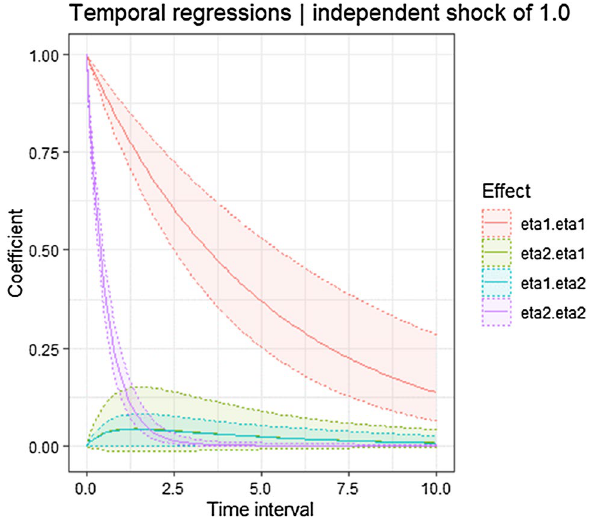
Figure 2. Representation of discrete time parameters of auto- and cross-effects of the Hierarchical Bayesian Continuous Time Dynamic Model of well-being and frequency of smartphone use. Legend: eta1.eta1 = auto- regressions of well-being; eta2.eta2 = auto-regressions of frequency of smartphone use; eta2.eta1 = cross- regressions of well-being on the frequency of smartphone use; eta1.eta2 = cross-regressions of the frequency of smartphone use on